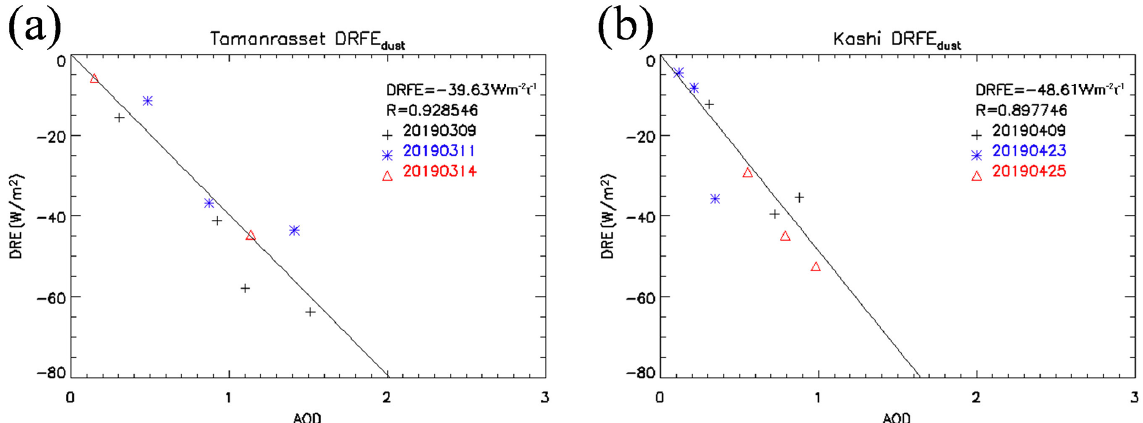
Figure 7. DRE dust in (a) March 2019 over Tamanrasset and (b) April 2019 over Kashi.